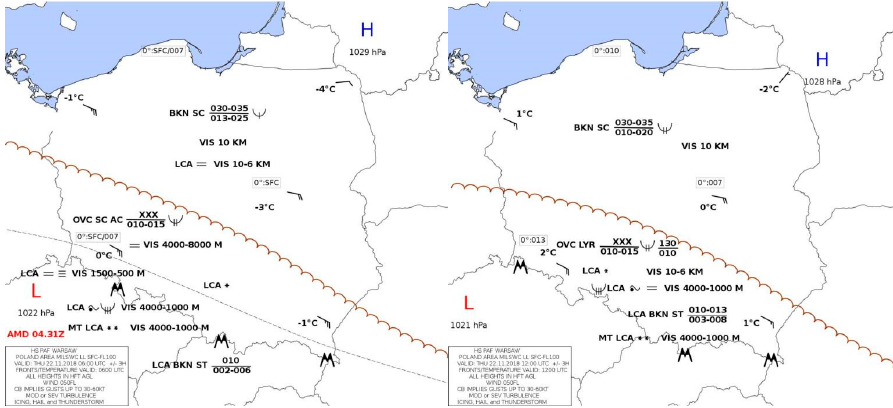
Figure 8. Graphical forecast for Poland for November 22, 2018, at 06:00 and 12:00 UTC ( ± 3 h) (based on Reference [43]).